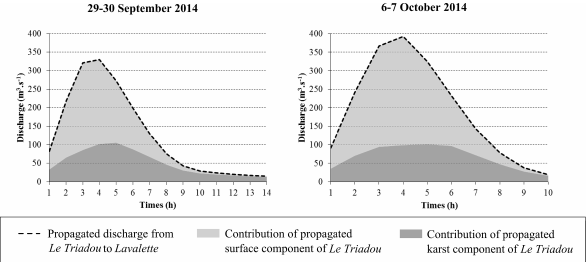
Figure 4. Karst and surface contributions for propagated floods of Le Triadou according Eqs. (2) and (3).